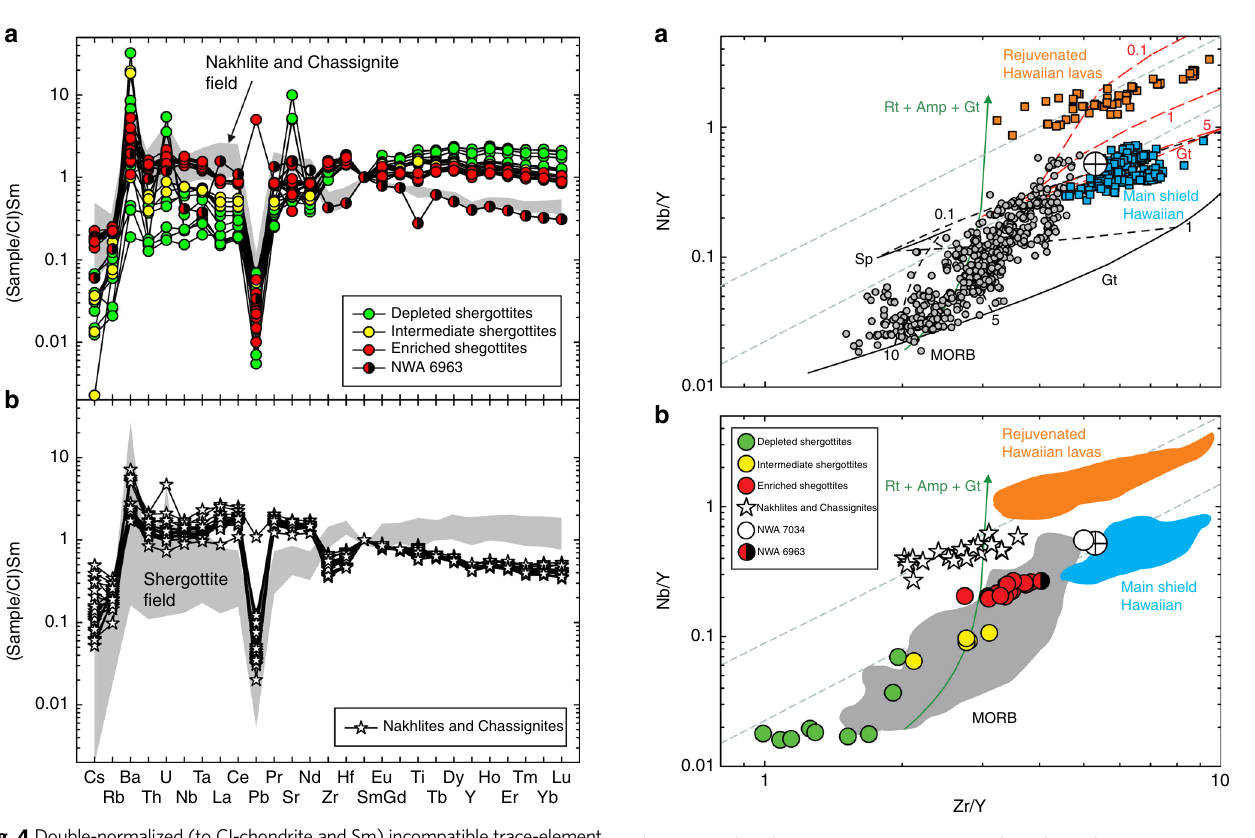
Fig. 5 Partial melting processes in Mars and Earth. Niobium – zirconium – yttrium discrimination diagrams showing a terrestrial mid-ocean ridge basalts (MORB) and Hawaiian main shield building and rejuvenated phase lavas. Partial melt models show melting of a terrestrial depleted mantle source and a metasomatized mantle source, containing amphibole and rutile. Gray dashed lines denote envelope of total variation seen in Icelandic samples using this type of plot. Lines in red are a primitive mantle model, lines in black are a depleted mantle model, and the green line is the exhaustion vector for rutile (Rt), amphibole (Amp), and garnet (Gt) in a metasomatized martian mantle source. Numbers (0.1, 1, 5, 10) associated with dashed tie lines between pure garnet and spinel endmembers are partial melt increments in percent, and Sp is spinel. b Comparison of martian meteorites with terrestrial lavas. Crossed circle is the terrestrial continental crust composition. Model parameters and data sources are given in the Methods section and analytical uncertainties are smaller than